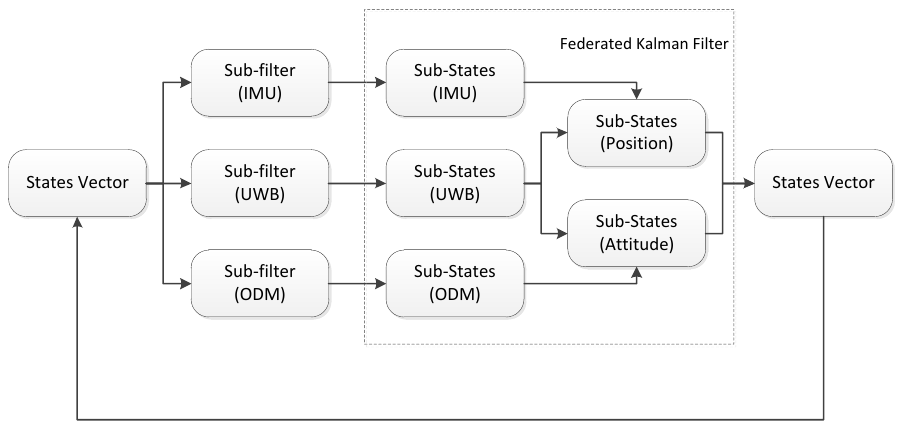
Figure 2. The overall structure of the